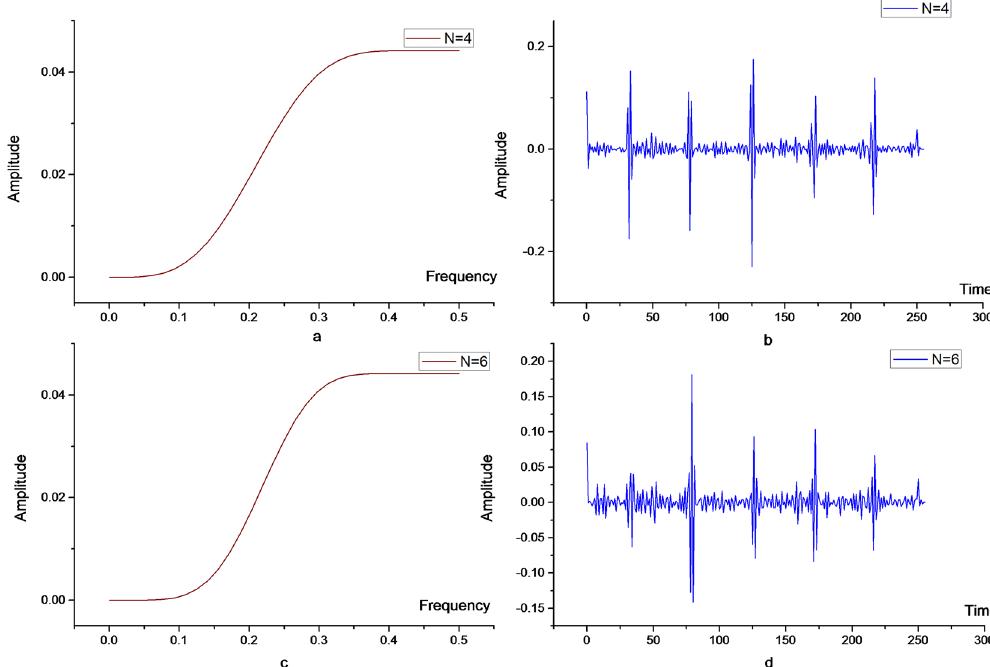
Figure 3. High frequency components of ECG signals after 4- (above) and 6-order vanishing moments (below).